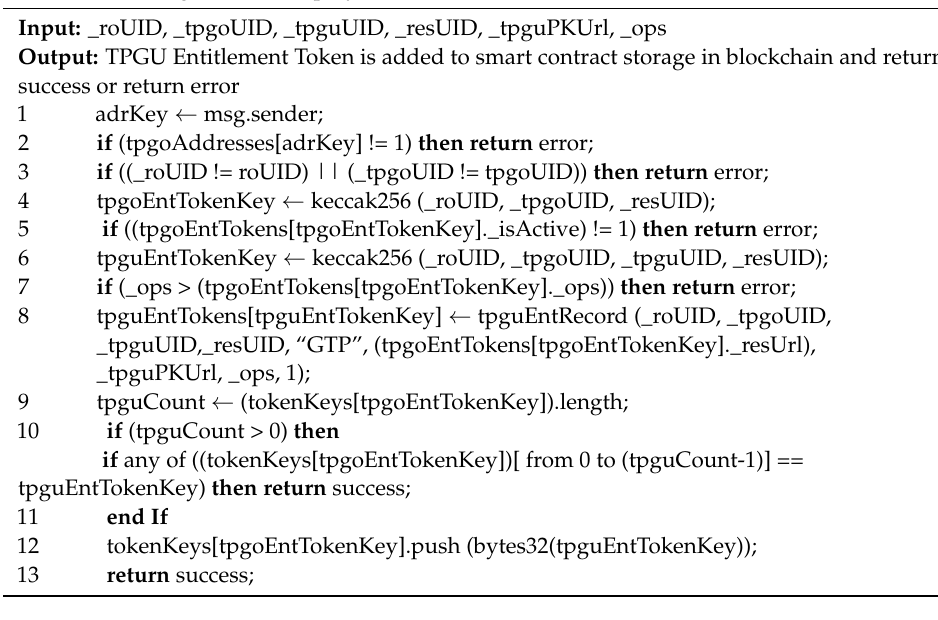
Algorithm 4: Algorithm to deploy a TPGU entitlement token in blockchain.